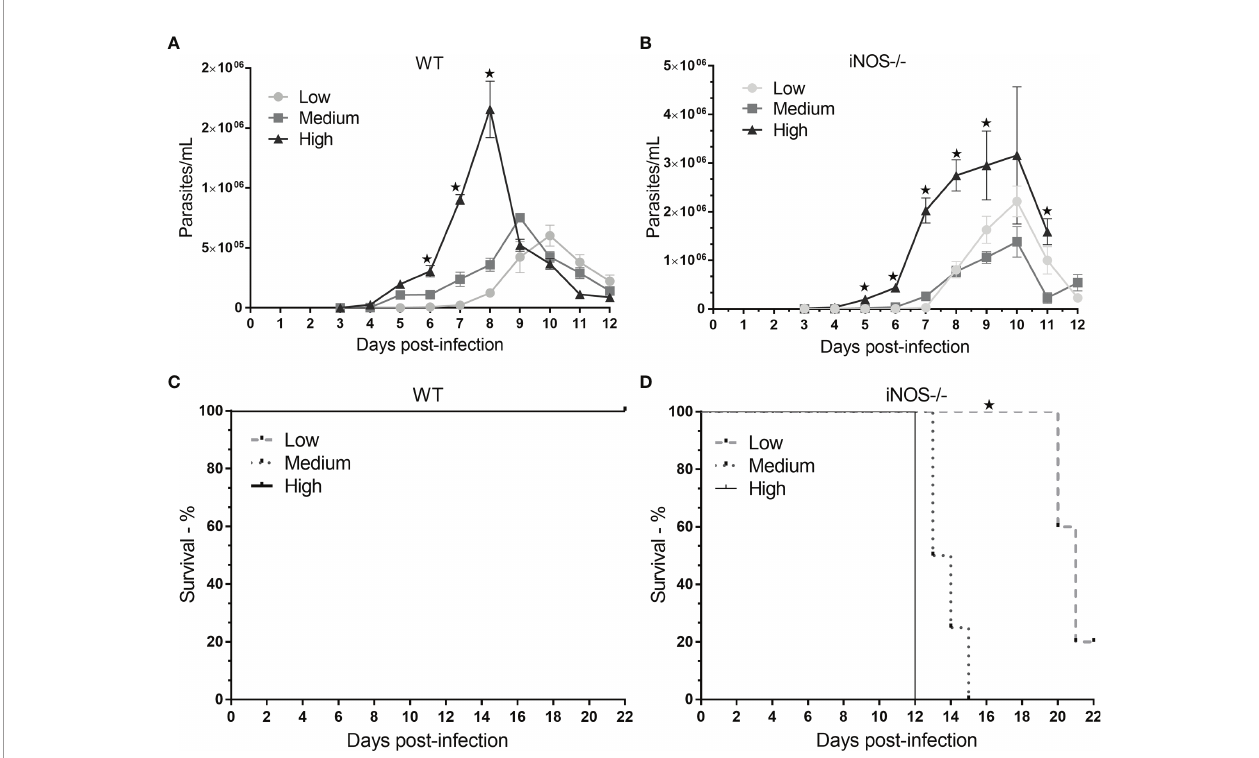
FIGURE 1 | Evaluation of parasitemia and survival in wild-type (WT) and knockout (iNOS -/- ) mice infected with different Trypanosoma cruzi inoculum concentrations. C57Bl/6 WT and iNOS -/- mice were infected with low (3 × 10 2 ), medium (3 × 10 3 ), or high (3 × 10 4 ) trypomastigote inoculum concentrations. In (A, B) , parasitemia was evaluated daily for the different pro fi les and research groups for 12 days. The number of parasites per milliliter was expressed in terms of mean and standard deviation. (C, D) shows the survival of the subgroups; the animals were followed until day 22 (censorship point), with the same experimental conditions for each phenotypic pro fi le and inoculum. Survival is represented in percentages. The * represents signi fi cant differences ( p <.05) (ANOVA followed by Tukey ’ s or Games – Howell test for parasitemia and log-rank test for